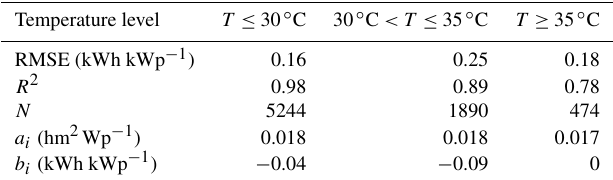
Table 3. Statistical and fitting parameters of PV yield